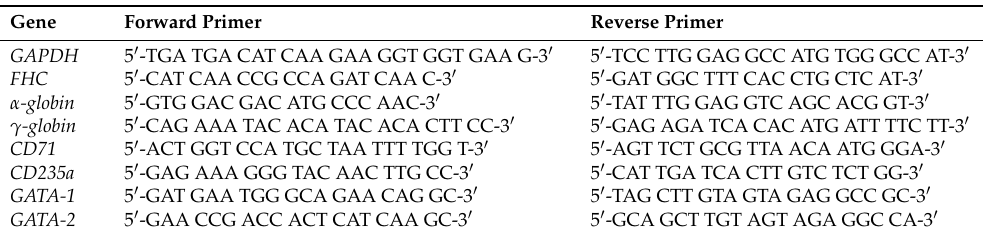
Table 1. Primers used in qRT-PCR